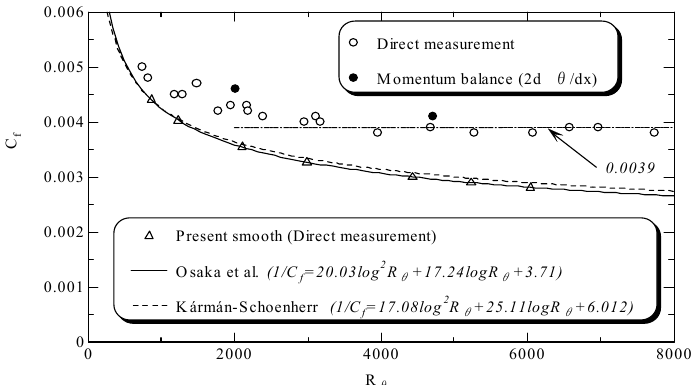
Fig.3 Local skin friction coefficient as a function of momentum thickness Reynolds number.